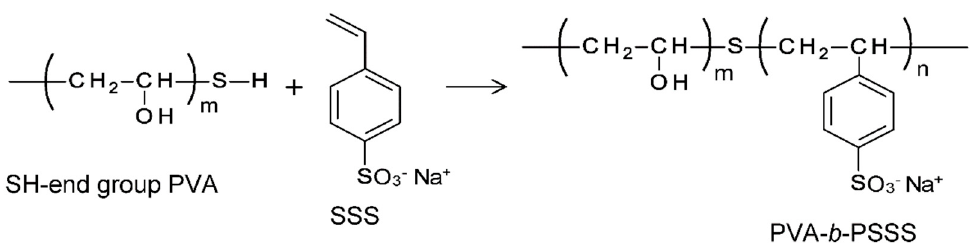
Figure 1. Chemical structure of SH end group PVA, SSA, and PVA- b -PSSS, and reaction scheme of PVA- b -PSSS.